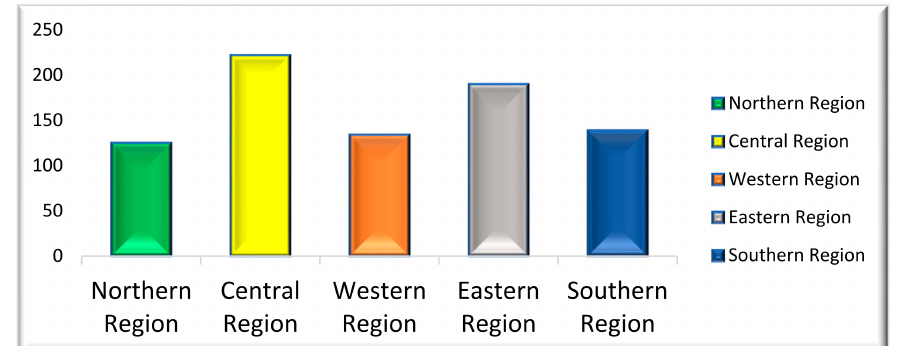
Figure 2. Distribution of regions in Saudi Arabia.